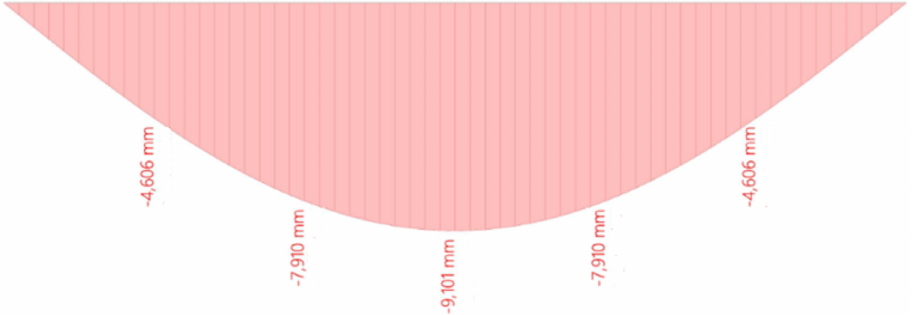
Figure 14. Results of static analysis of vertical displacements of the beam